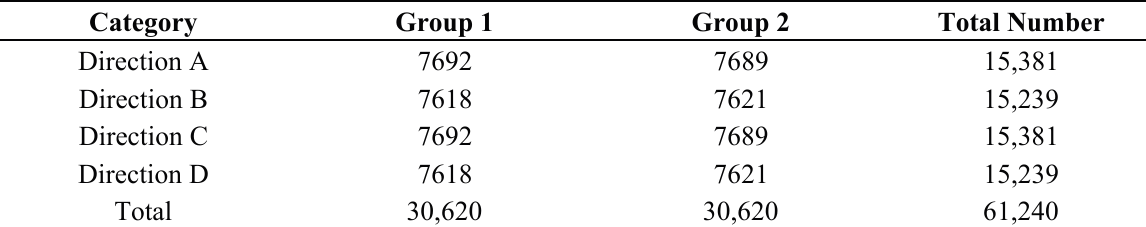
Figure 4. Examples of images: ( a ) Direction A; ( b ) Direction B; ( c ) Direction C; and ( d ) Direction D. Table 3. Number of images in each group and